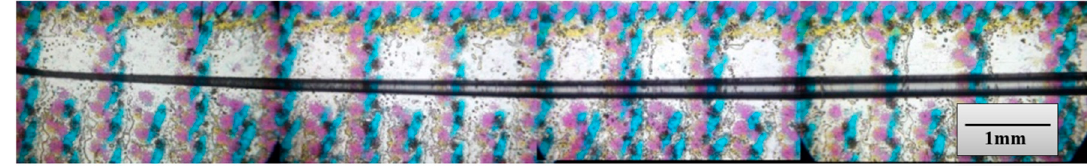
Figure 3. Microscope picture of 10 mm long POF tapper with initial OD of 250 μ m.